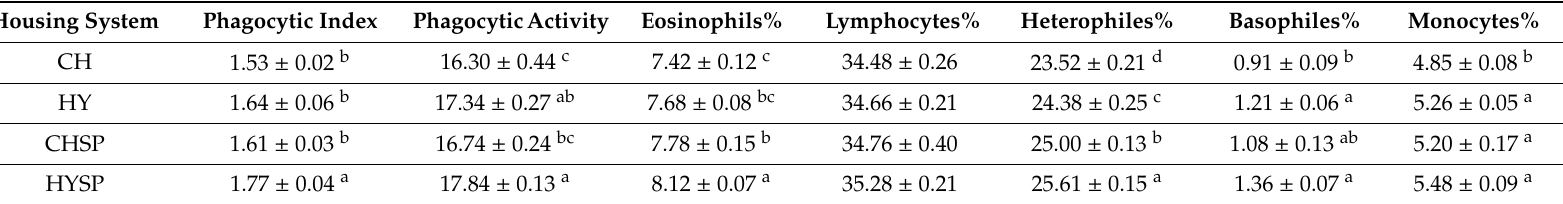
Table 4. E ff ect of di ff erent housing systems on cellular immunity of Pekin